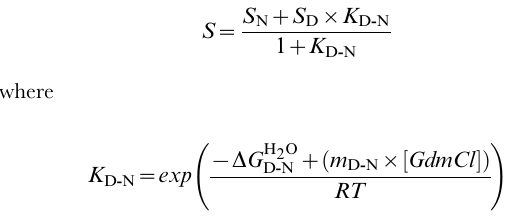
Figure S2 Evidence for the denatured threaded state prior to full unfolding. The trajectory shows the energy levels of the folded- (around 0) and unfolded basins (around 250) for wt Reduced (black ) and wt Oxidized (red) respectively. The plot also indicate that there are several unsuccessful unfolding attempts on the wt Oxidized route from N to U. The unfolded chain is trapped inside loop a 4 - a 5 (helix 2 and 3 shown in white in the structure B), leading to a denatured threaded state. This represents the typical subpopulation during the unfolding of leptin. The structures show the different states, i.e. the native state (A), trapped threaded state (B) and the unfolded unthreaded state (C), from the folding routes in an All-Atom representation. Figure S3 The All-Atom simulations of leptin. The free energy landscape F(Q, RMSD) together with the free energy plot of the All-Atom simulation ( wt DynamicDisulphide ). The plots show that there are no significant shifts of the denatured and native basins. As appose to the broad TS seen in the oxidized state in Figure 3, we see the potential of an intermediate formation in the All-Atom model. Figure S4 Contact maps for leptin showing the proba- bility of contact formation at the TS. The contact map is shown at the TS (Q= 0.4). Leptin displays a diffuse TS where all helices, except a 1, are involved. They also indicate/show that the TS is very similar between the different C a - versus the SBMs.